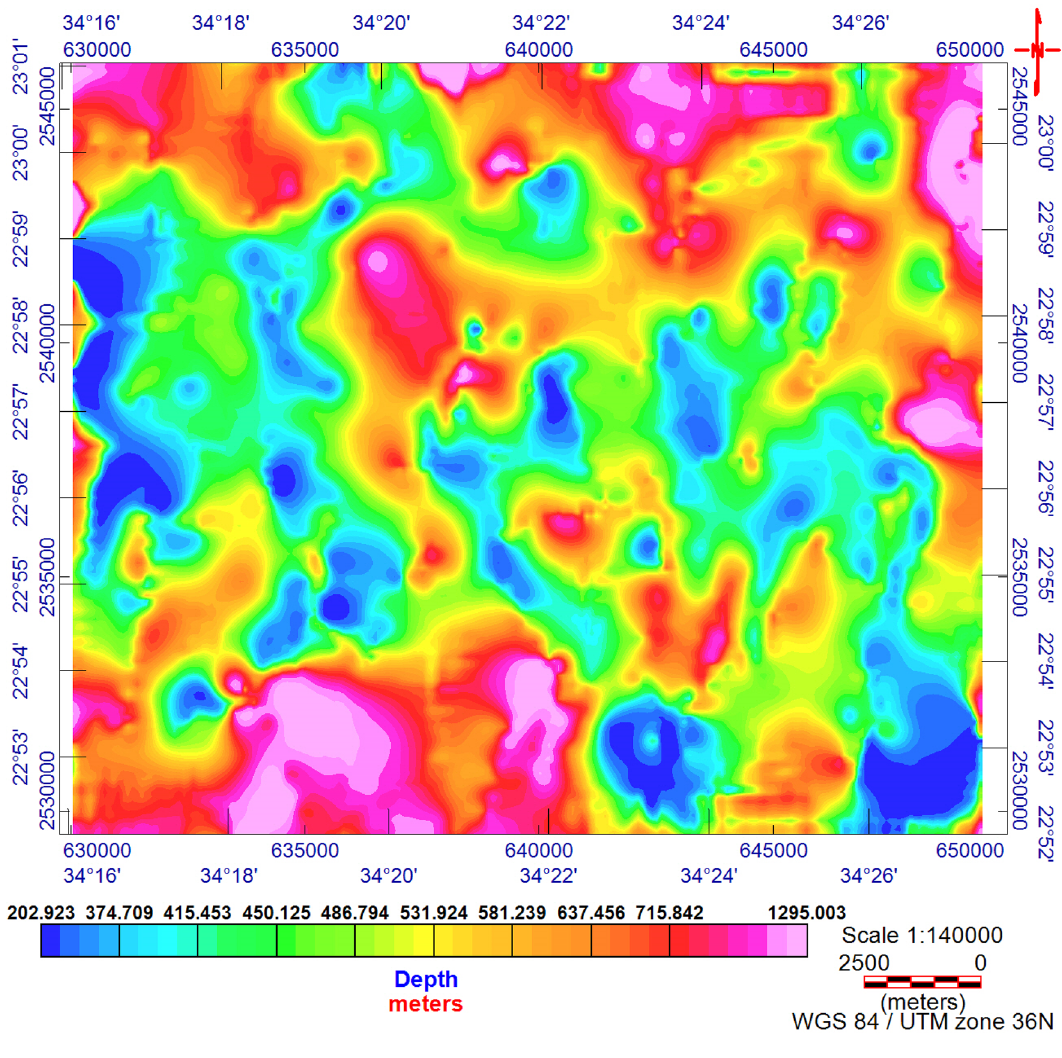
Figure 8. The Euler depth map of Akab El-Negum